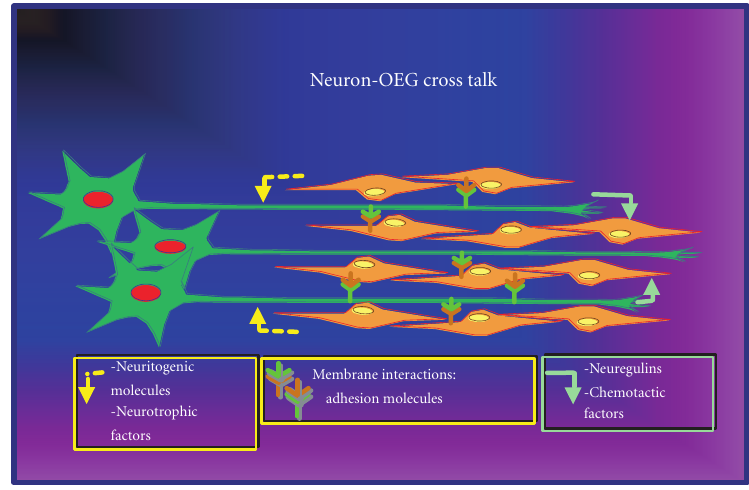
Figure 1. Neuron-OEG cross talk. OEG and extending axons of olfactory sensory neurons interact through membrane adhesion molecules (represented by the Y symbols). OEG also bear receptors to neuregulins and possibly to other chemotactic factors produced by the developing neurons (solid arrows) and/or other cells. Furthermore, OEG produce and secrete neurotrophic factors and neuritogenic extracellular matrix proteins which interact with developing neurons (dashed arrows). The characteristics of OEG together with their influence on glial scarring and their ability to migrate within the CNS might be responsible for their axonal-regenerative properties in CNS injuries. OEG permit CNS axonal regeneration by acting as a vehicle, ensheathing, driving, and nurturing growing axons through a hostile